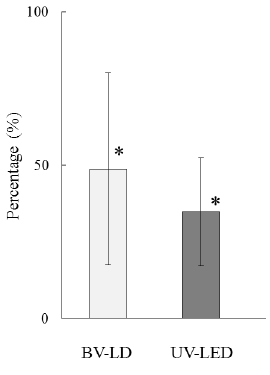
Figure 6. Adherence of Porphyromonas gingivalis to each specimen. Percent adherence with exposure to that without exposure after titania treatment. doi: